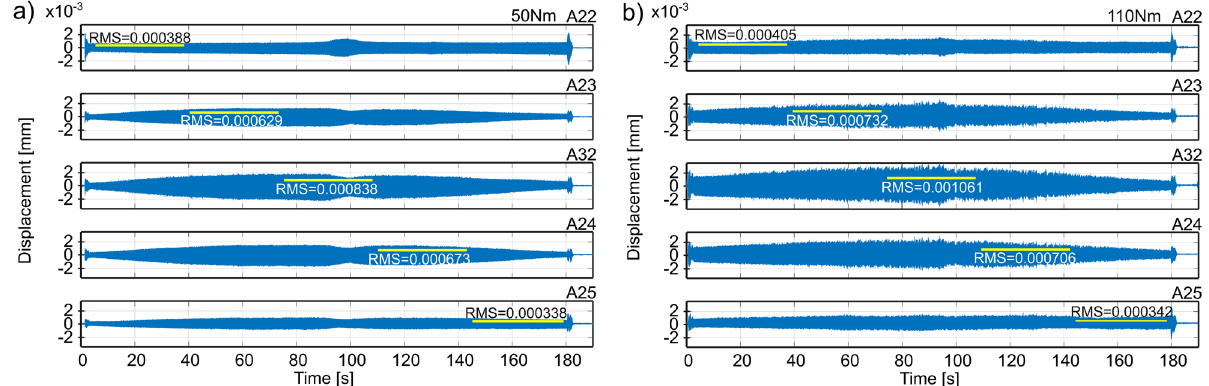
Figure 6. Displacements of vibrations of the workpiece during full milling, obtained on the basis of measurements from accelerometers located along surface 1 at tightening the mounting screws with a torque of: